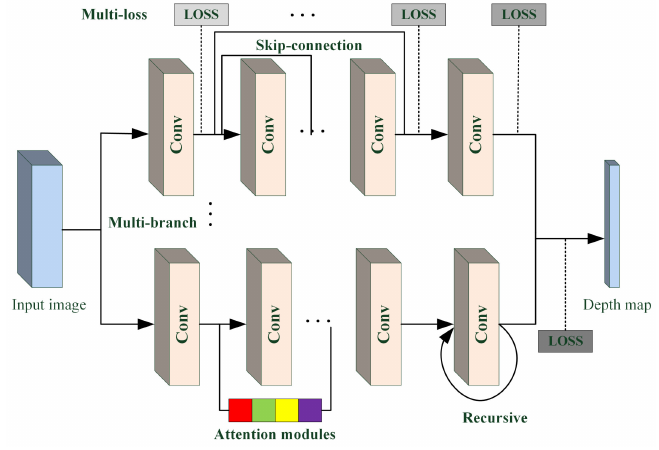
Figure 1. Diagram of the supervised CNN-based image-depth-estimation model. Conv stands for convolutional